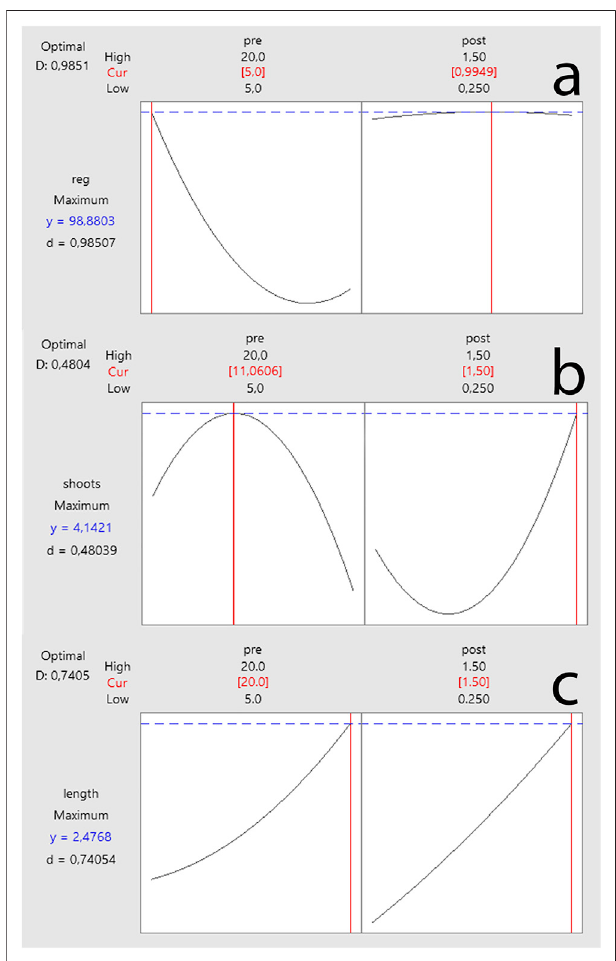
FIGURE4| Response prediction ofindividual output variableson invitro regeneration of common bean (A) regeneration, (B) shoot count, and (C) shoot